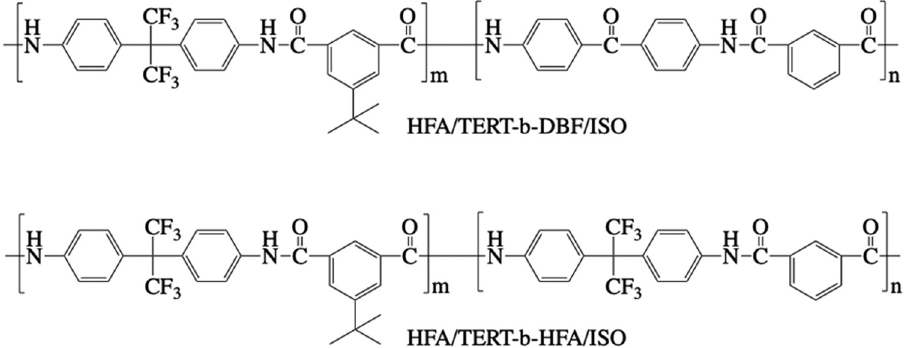
Figure 8: General structure of the block copolyaramids having di ff erent gas permeable and barrier blocks ( 67,68 )